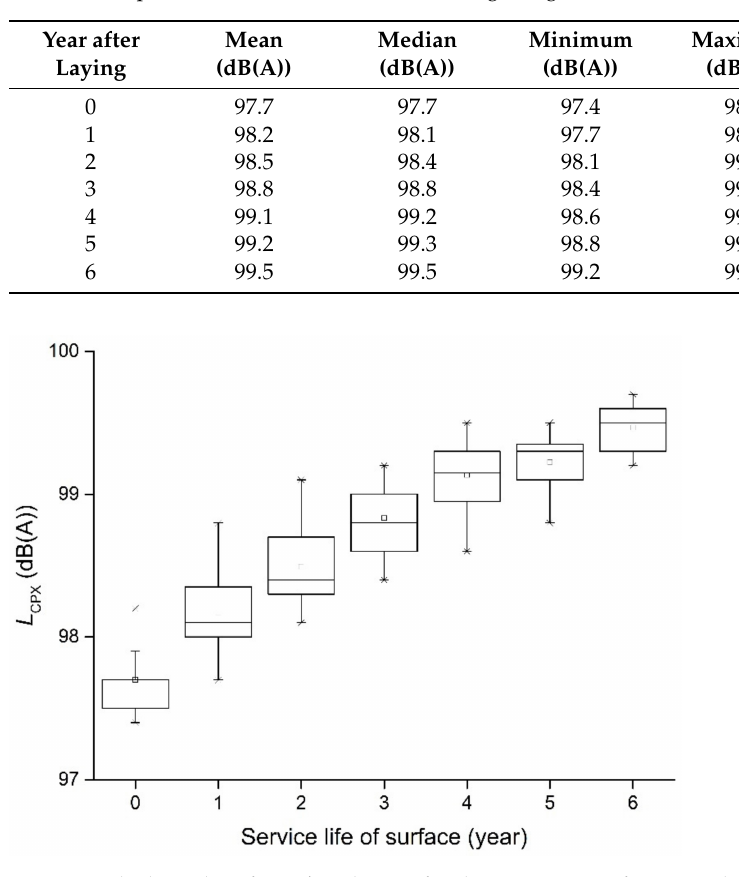
Figure 9. The box plot of tyre/road noise for the SMA 11S surface in each year. Median value for each year of service life was again inserted into the chart. Tyre/road noise increases as the surface ages. When the points are fitted to a linear equation, the coefficient of determination equals 0.970; when they are fitted to exponential function, it equals 0.987. Therefore, exponential fitting was selected, the graphical representation and equation of which can be seen in Figure 10.